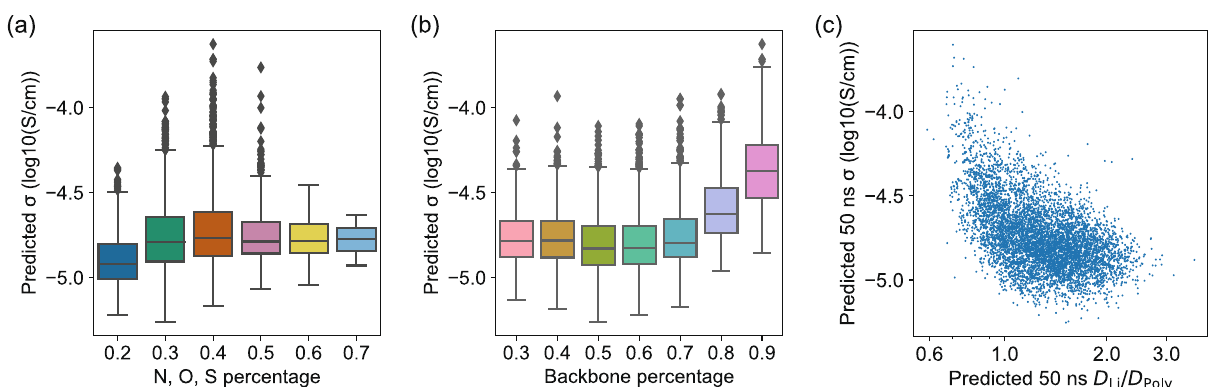
Fig. 6 Relation between several descriptors and predicted 50 ns MD Li-ion conductivity for polymers in the 6247 search space. a The percentage of N, O, S atoms to non-hydrogen heavy atoms in the polymer structure. b The percentage of backbone atoms to non-hydrogen heavy atoms in the polymer structure. c The ratio between predicted Li-ion and polymer diffusivity, corresponding to the degree of decoupling between Li ion and polymer